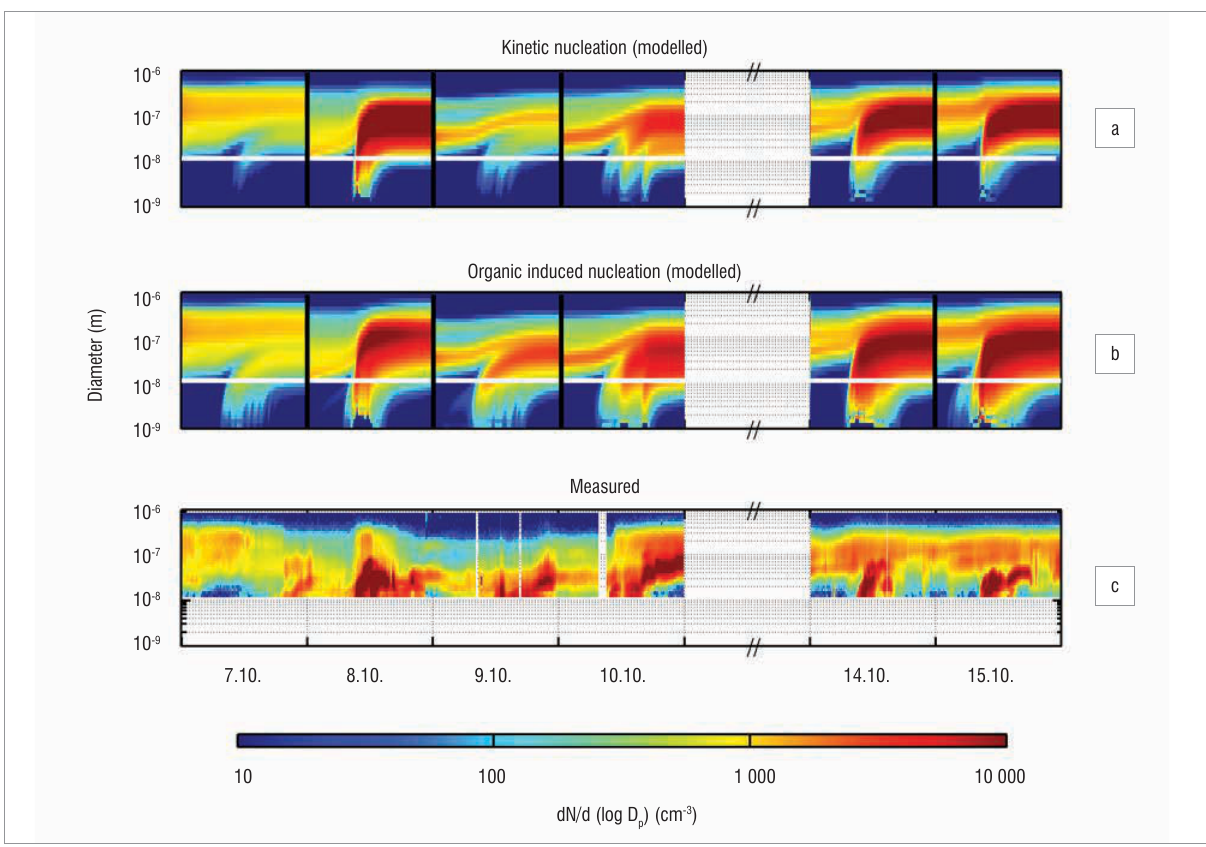
Figure 7: Modelled (a) kinetic nucleation and (b) organic-induced nucleation and (c) measured particle number size distribution for 7–10 and 14–15 October 2007. In (a) and (b) the white line shows the detection limit of the instrument at 10 nm, and the black lines model initialisation in the beginning of each day. The simulated concentrations are from a model height of 4.0 m.